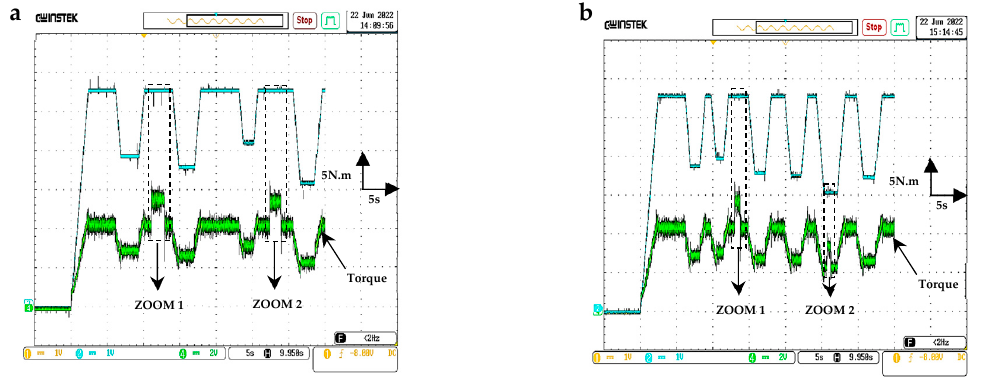
Figure 18. Electromagnetic torque and speed response for speed profile 1 and 2.